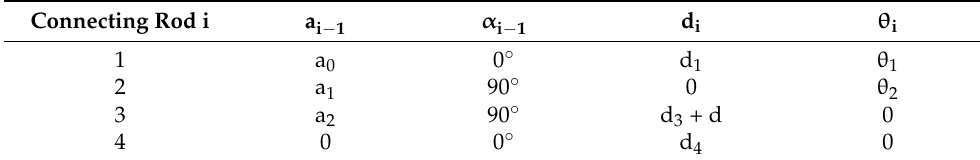
Table 2. Parameter table of cutting head connecting rod. Connecting Rod